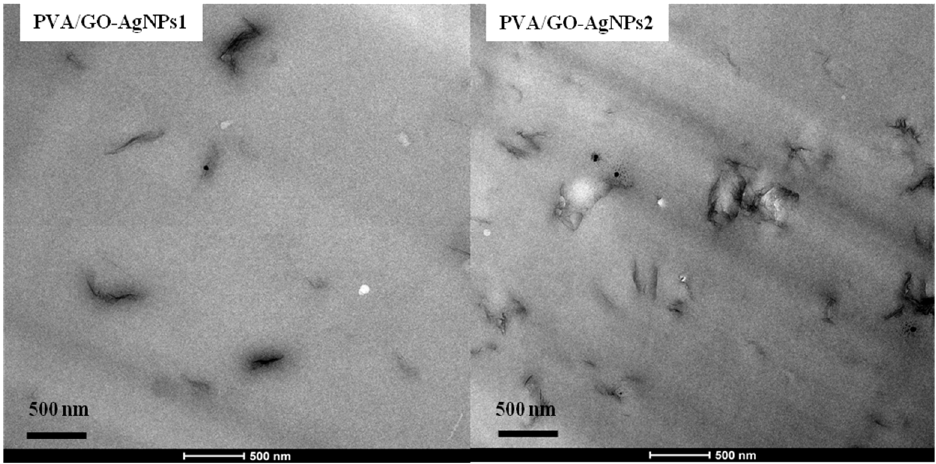
Figure 3. TEM images of PVA/GO–AgNPs nanocomposite films with 1 wt % and 2 wt % GO–AgNPs.